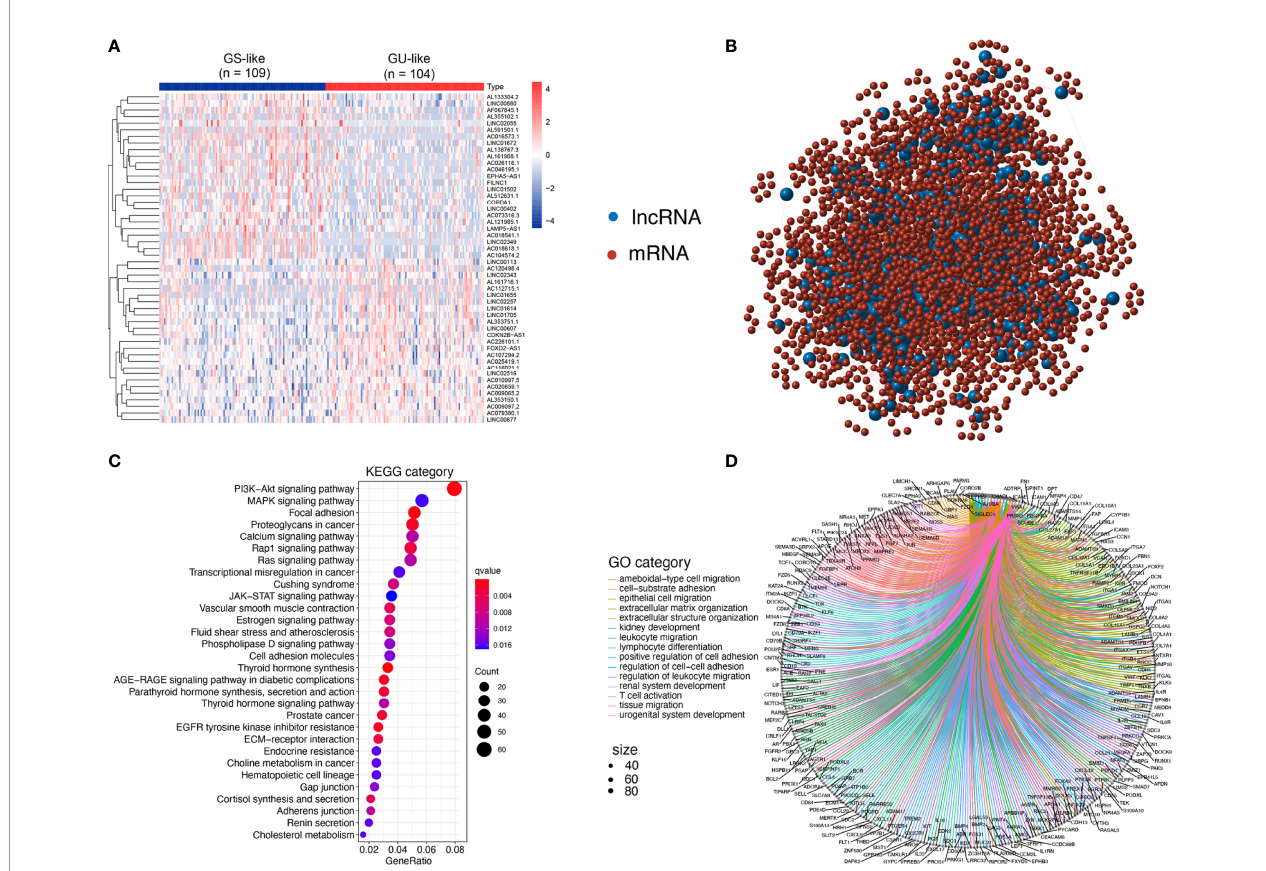
FIGURE 2 | Identi fi cation and functional annotations of GIlncs in patients with PTC. (A) Expression patterns of 558 candidates GIlncs in 487 PTC patients. The left blue cluster is the GS-like group, and the right red cluster is the GU-like group. (B) Co-expression framework of GIlncs and paired mRNAs based on the Pearson correlation coef fi cient. The red circles represent lncRNAs, and the blue circles represent mRNAs. Functional enrichment analysis of (C) KEGG and (D) GO for mRNAs co-expressed